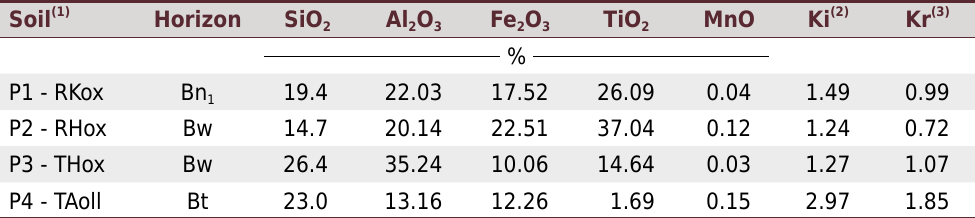
Table 3. Chemical composition, expressed in the oxide basis of the element, as determined through sulfuric attack and Ki and Kr indices for samples from the Southern Espinhaço Mountain Chain and Upper Jequitinhonha